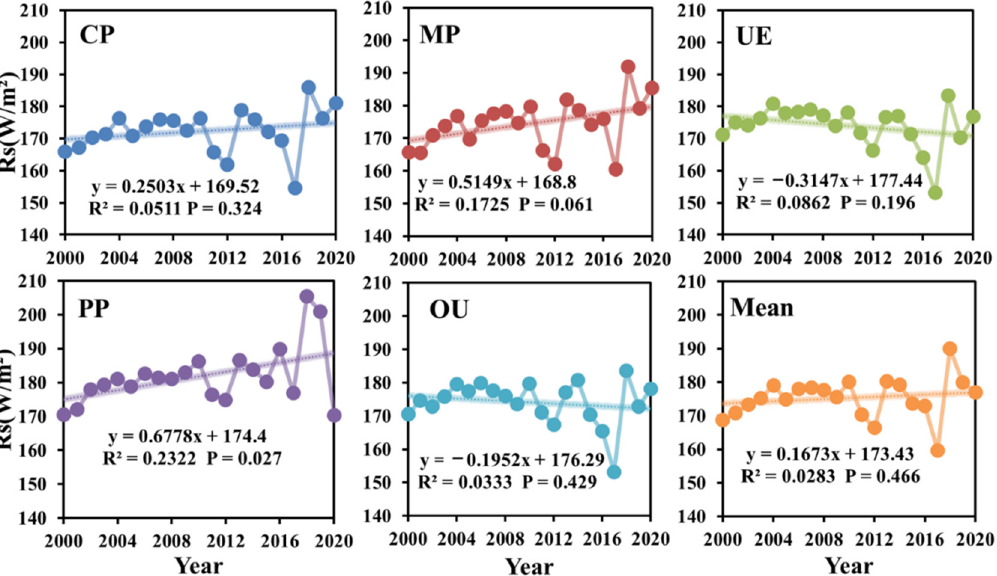
Figure 7. Net radiation (R s ) trend of different land use types in the Yangtze River basin from 2000 to 2020.